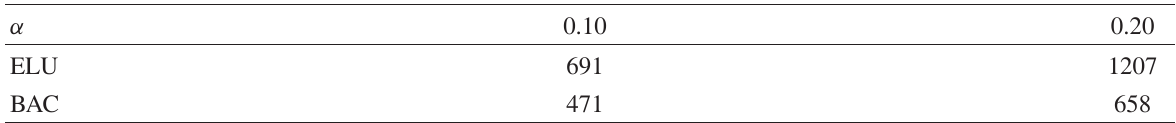
TABLE 4: The number of genes after